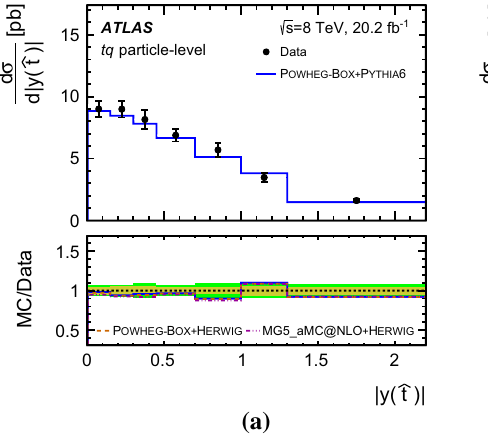
data points denote the total uncertainty. The inner ( yellow ) band in the bottom part of each figure represents the statistical uncertainty of the measurement, and the outer ( green ) band the total uncertainty